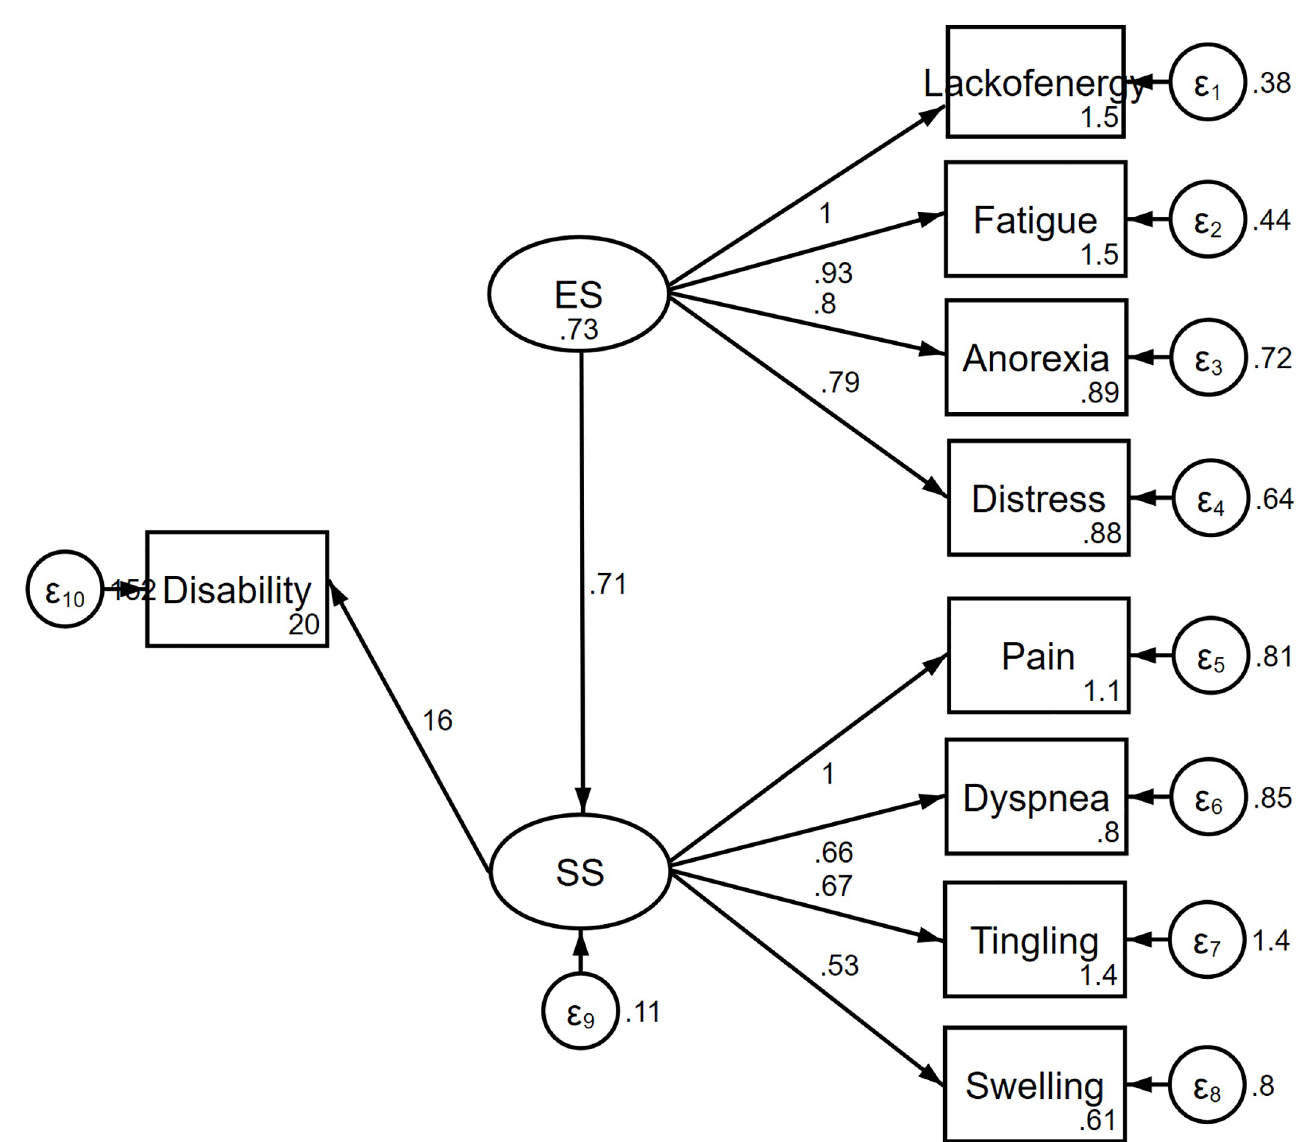
Fig 3. Complex model of the relationship between symptoms and disability. ES, experienced symptoms; SS, somatic sensation.